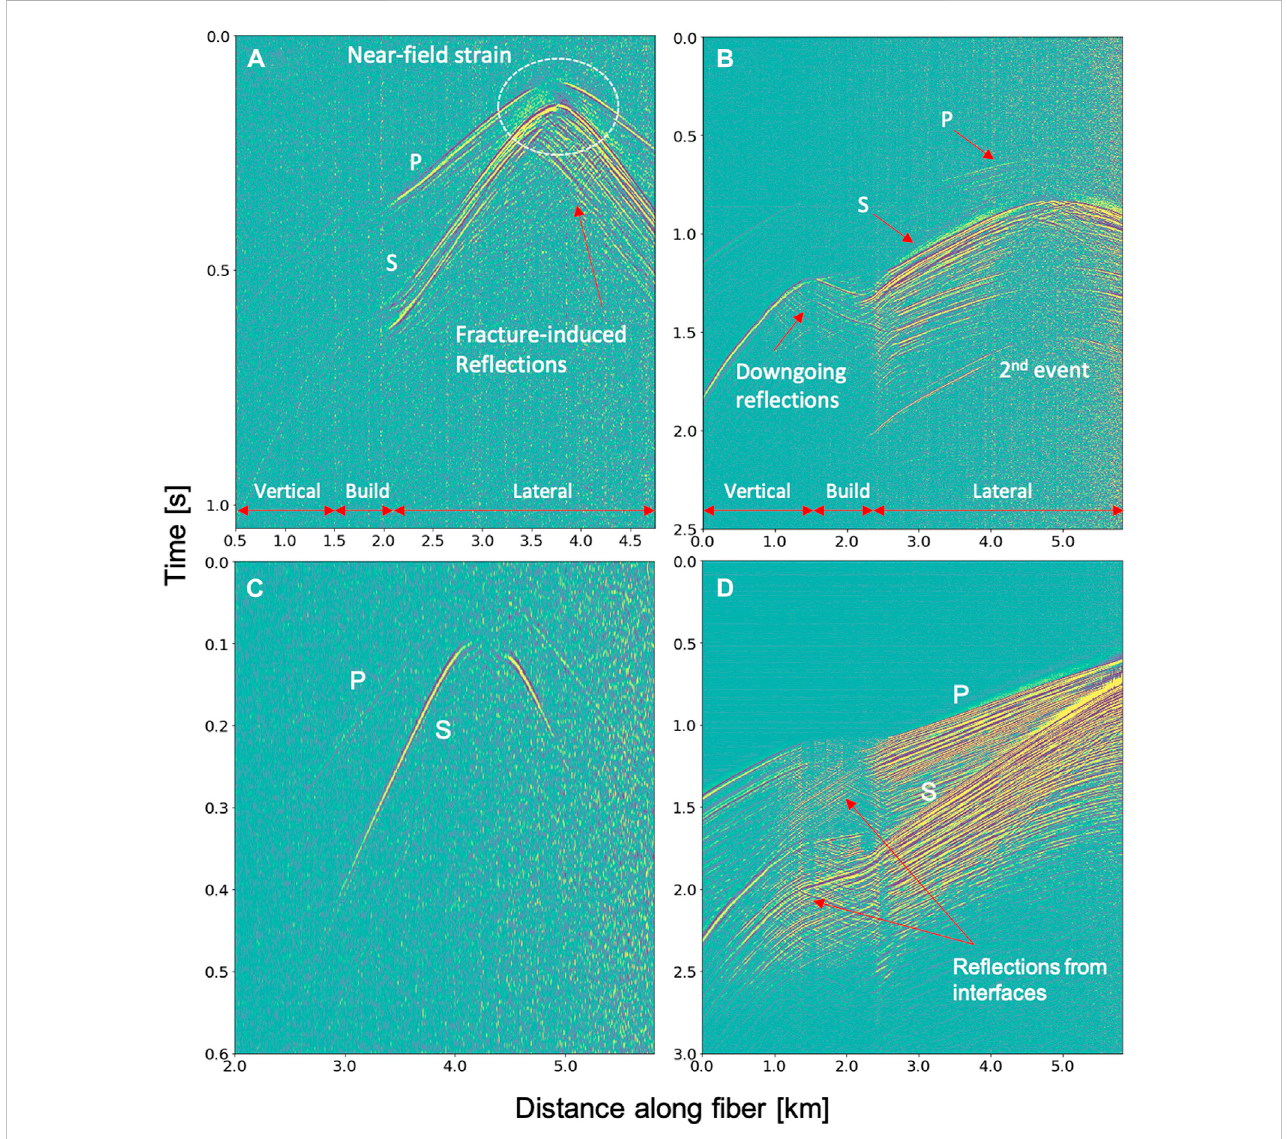
FIGURE 2 Examples of microseismic events detected by permanent (cemented) DAS fi bers in horizontal wells. Events in (A,B) indicate P- and S- arrivals, fracture- and interface-induced re fl ections, guided wave, shear wave splitting, and near- fi eld strain; event (C) is faint but typical of our DAS microseismic data; (D) shows a distant event beyond the well toe.